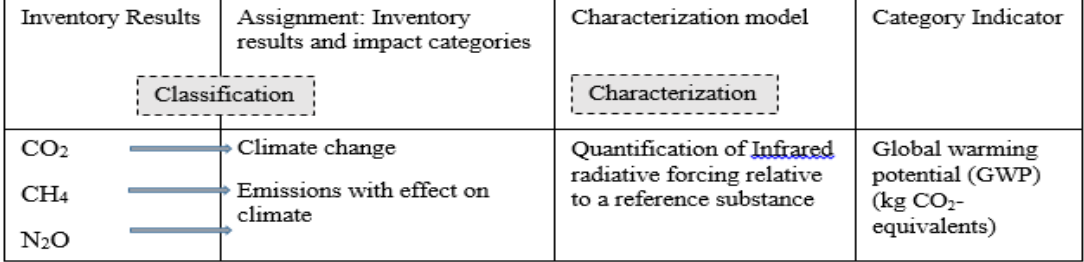
Figure 6: Principle of classification and characterization in the phase life cycle impact